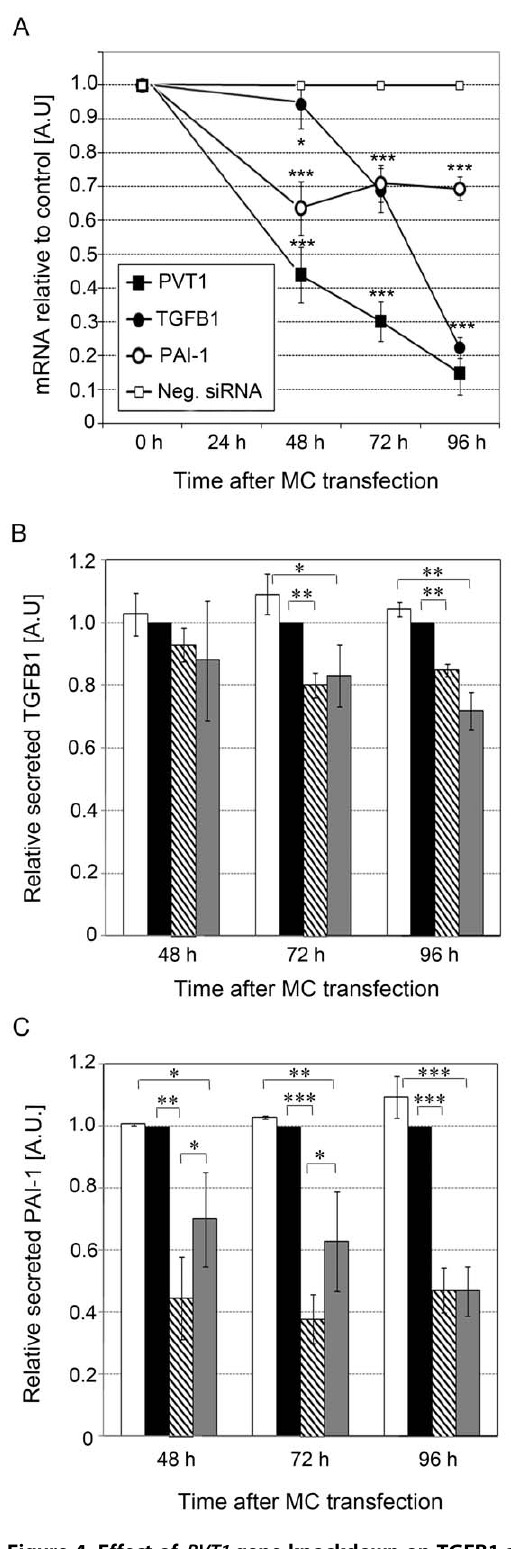
Figure 4. Effect of PVT1 gene knockdown on TGFB1 and PAI-1. ( A ) PVT1 , TGFB1 and PAI-1 mRNA levels following MC transfection with PVT1 siRNA. Data were obtained by qPCR analysis and presented as mRNA fold-increase compared with Neg siRNA. Non-transfected (NT) MC were used as a second negative control. Quantification of secreted TGFB1 ( B ) and PAI-1 (C) in media from MC after cell transfection with PVT1 siRNAs. Data were obtained by sandwich ELISA and compared